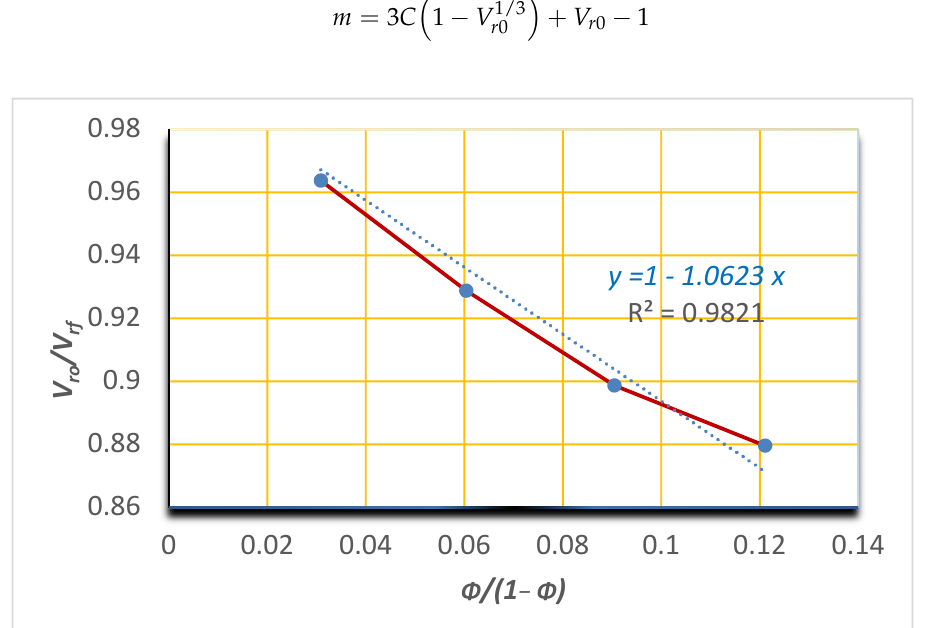
Figure 3. Kraus plot for EPDM/hemp fiber composites.